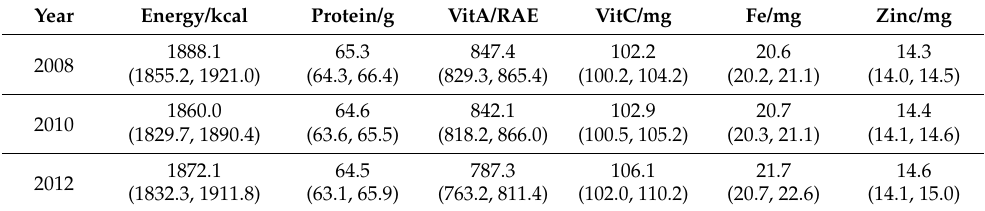
Table A1. Daily nutrient availability per capita in Mexico,